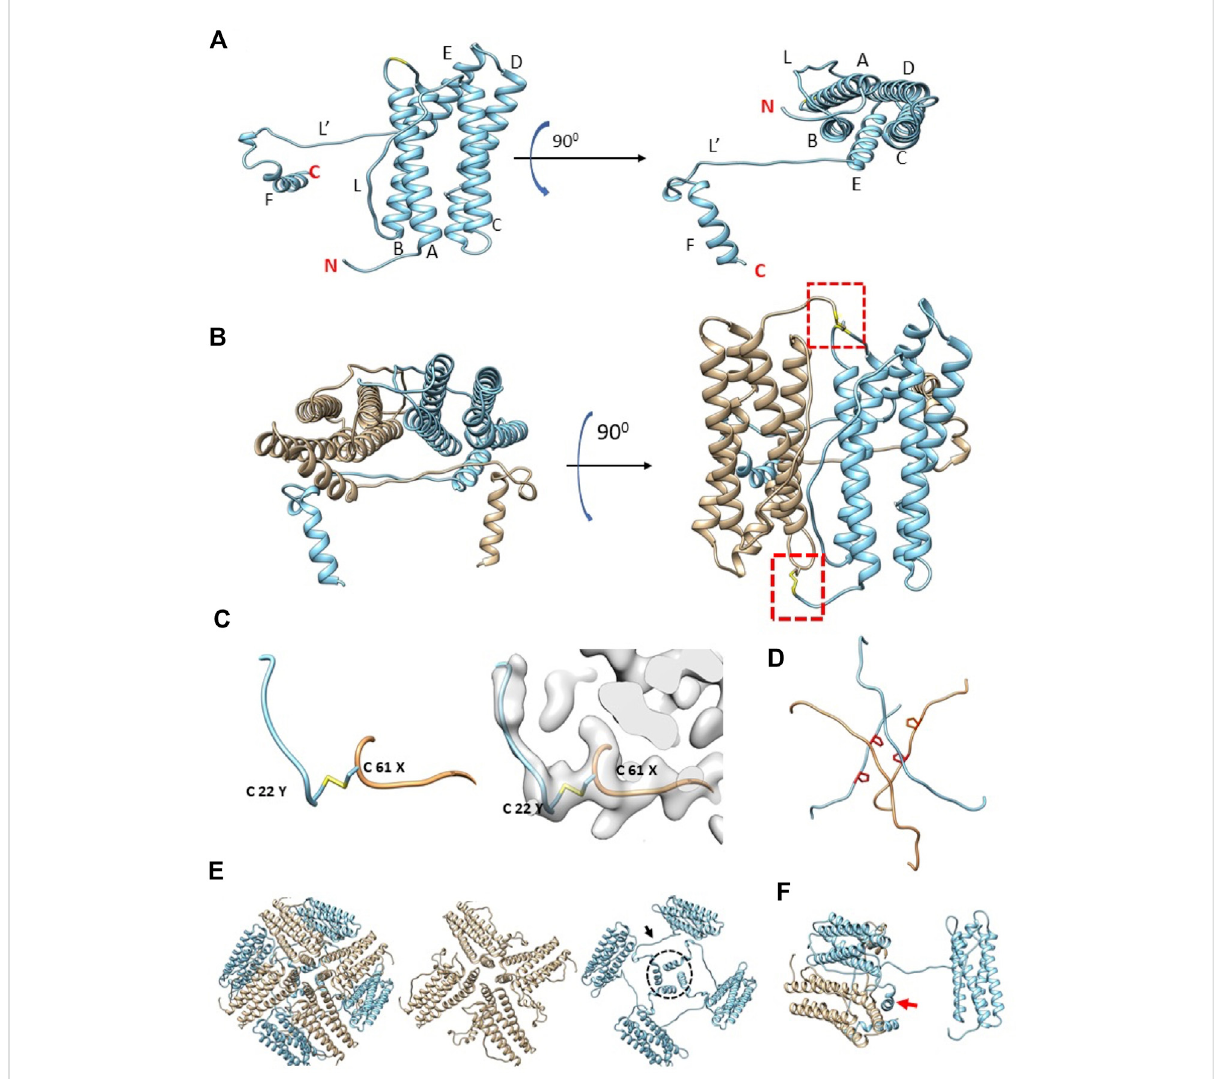
Structural organization of artemin. (A) Artemin monomer with helices A-F and loops L and L ′ annotated. The extra length of helix E for artemin comparedtoapoferritinhelpspositionloopL ′ torunalongtheinsideofthecoreshellofarteminbeforehelixFturnsinwardintotheartemincavity.N andCterminiareindicatedinred. (B) Artemindimerwithantiparallelmonomerscoloredseparately(tanvs.skyblue).Dashedborderindicatesareaof the Cys22-Cys61 disul fi de bond. (C) A zoomed in view of the region in the dashed boundary in (B) shows the Cys22-Cys61 disul fi de bond, with and without the map density. (D) The L and L ′ loops from respective monomers forming the hashtag arrangement. Side chains of Pro198 and Pro201 are shown in red for each loop. (E) Four artemin dimers around a 4-fold axis. The conventional 4-fold axis has loops from monomers containing Cys172 (tan) similar to apoferritin arrangement. In addition, the complementary monomers (sky blue) in apoferritin have a second arrangement (dashed circle) where loop L ’ (arrow) and helix F contact extend towards the neighboring dimer. (F) Helix F (red arrow) interacts with both monomers from the neighboring